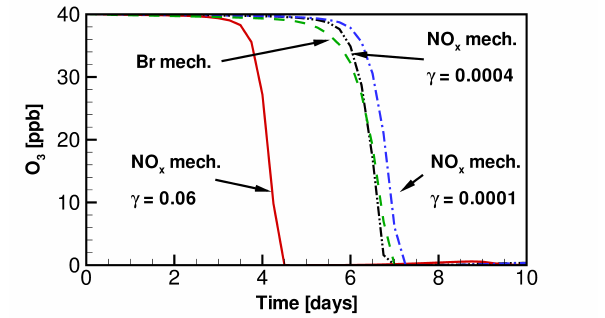
Fig. 14. Ozone depletion rates with different values of the BrONO 2 hydrolysis uptake